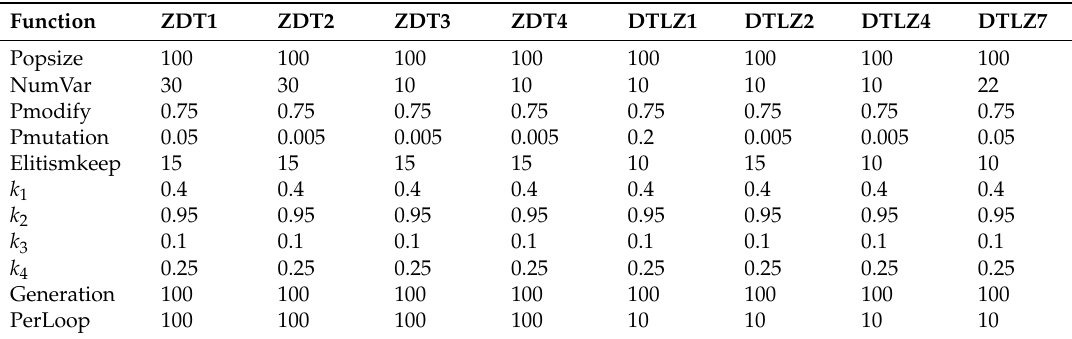
Table 1. Parameters used by test